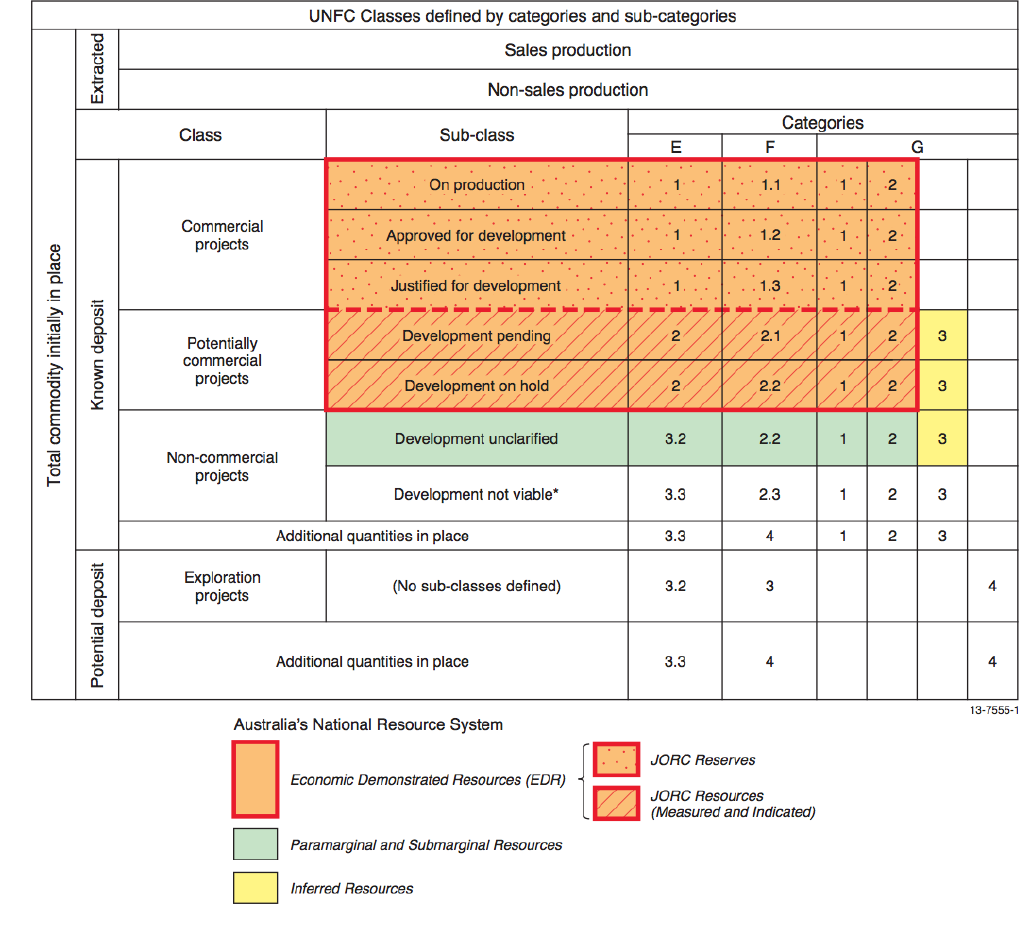
Figure 5: Correlation of Australia’s national mineral resource classification system with the UNFC system (Geoscience Australia, 2014, p. 172), criteria (E) economic and social viability, (F) project status and feasibility (F), and (G) geologic